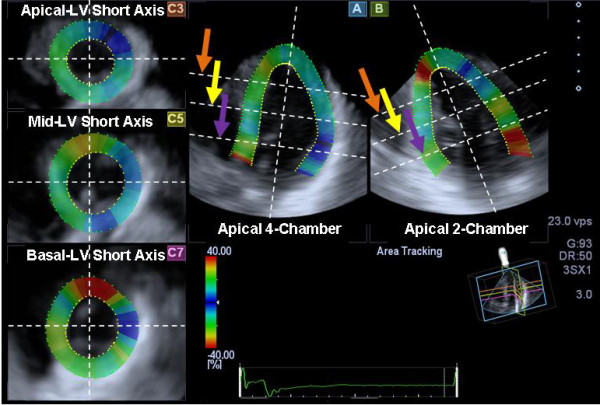
Example of images generated from a pyramidal three-dimensional dataset: (A) apical 4-chamber view, (B) 2-chamber view, (C3) apical left ventricular (LV) short-axis view (orange arrow), (C5) mid-LV short-axis view (yellow arrow), and (C7) basal LV short-axis view (purple arrow).